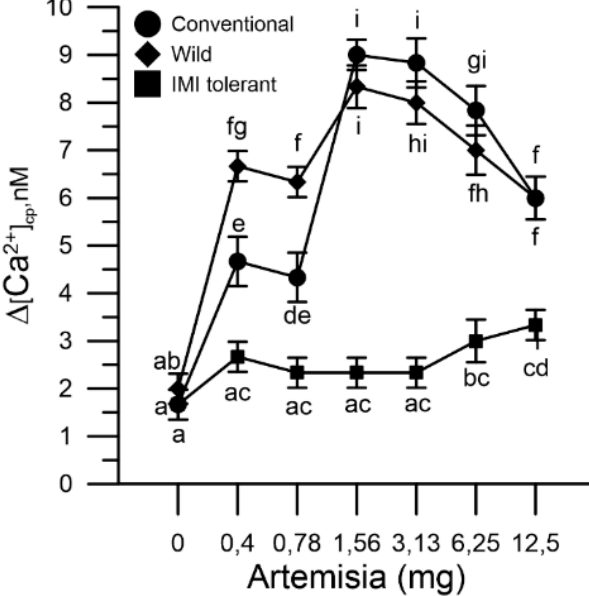
Figure 3. Effect of mugwort in the Ca 2+ entry of different sunflower pollen grain: conventional ( ● ), wild ( ♦ ) and ‘IMI-tolerant’ ( ■ ), after the addition of CaCl 2 to the incubation medium. The results are expressed as ∆ [Ca 2+ ]cp (nM), reporting the signal changes detected between the beginning and the end of the fluorometric measurements (1 min) and represent the means ± SEM of three independent tests. Statistically significant differences are indicated by different letters, whereas identical letters highlight non-significant trends. SEM, standard error of the mean.